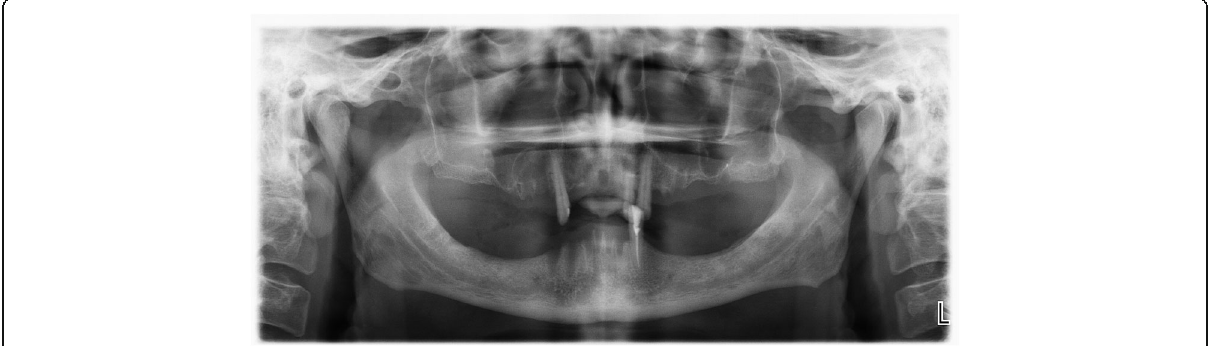
Fig. 1 A panoramic radiography before surgery